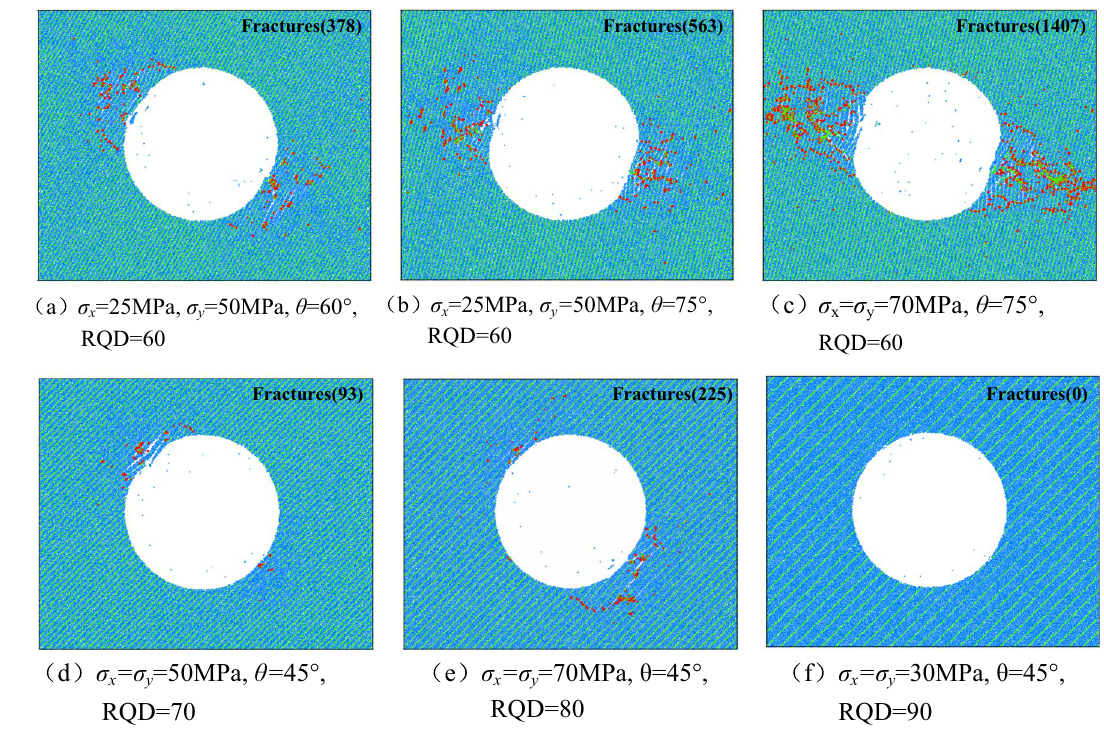
Fig. 12 Failure results under different conditions Note: The green line represents the joint and the red line represents